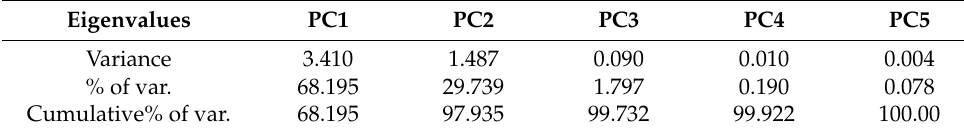
Table 8. The eigenvalues of the correlation matrix (25